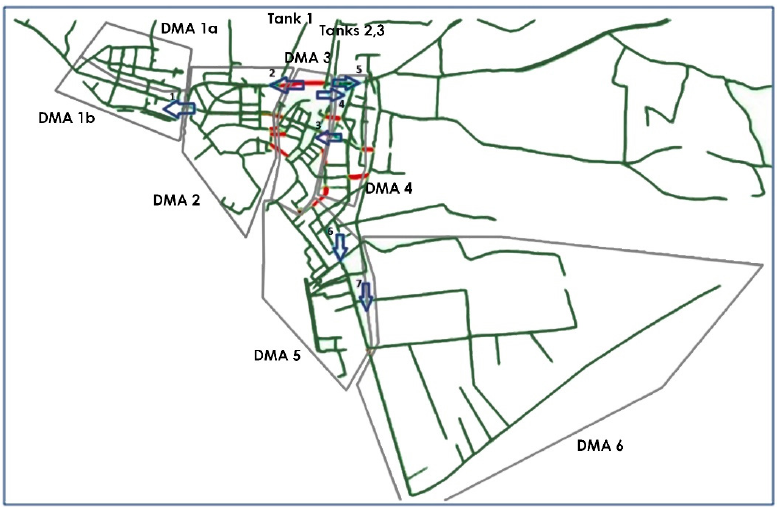
Figure 2. District Metered Areas (DMAs) formation based on the optimal pressure at the critical node of each DMA. Table 1. Scenario No1 (Initial Settings. No DMAs_No Pressure Reducing Values (PRVs)): a) Critical nodes per DMA based on the water pressure. Respective water age and water demand values; b) Critical nodes per DMA based on the water age. Respective water pressure and demand values. Scenario No1: noDMAs_no PRVs